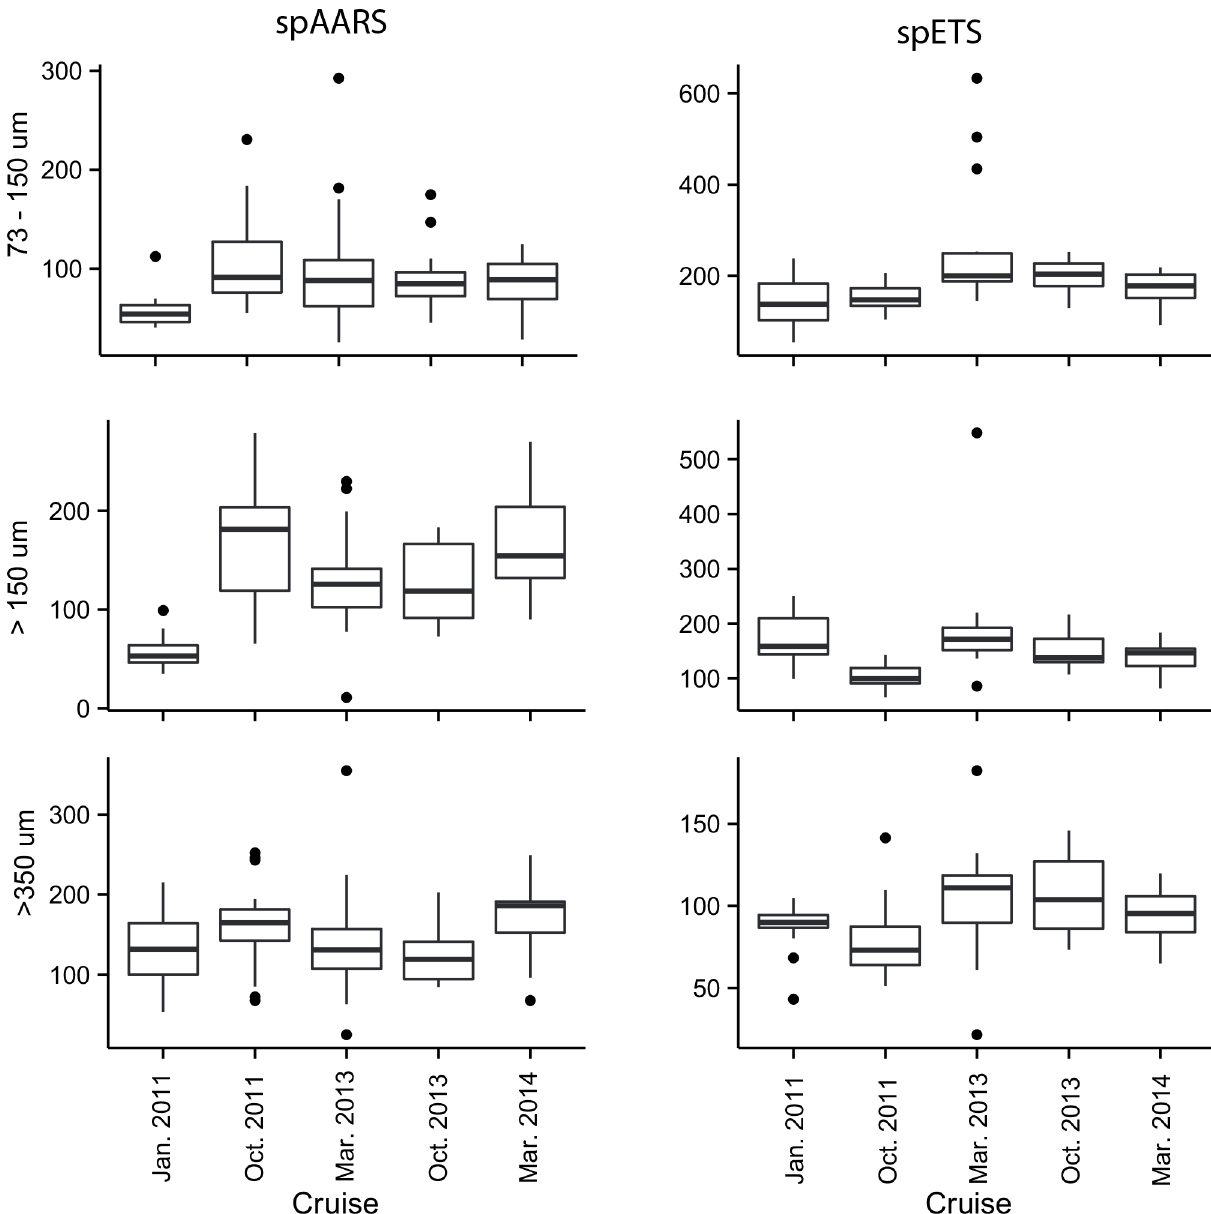
Fig 4. spAARS activity (nmol PPi hr -1 mg protein -1 ) and spETS activity ( μ L O 2 hr -1 mg protein -1 ) in 3 size fractions (73 – 150 μ m, > 150 μ m and > 350 μ m) of zooplankton samples collected from 5 cruises to the Kimberley coast, contrasting cruise differences.